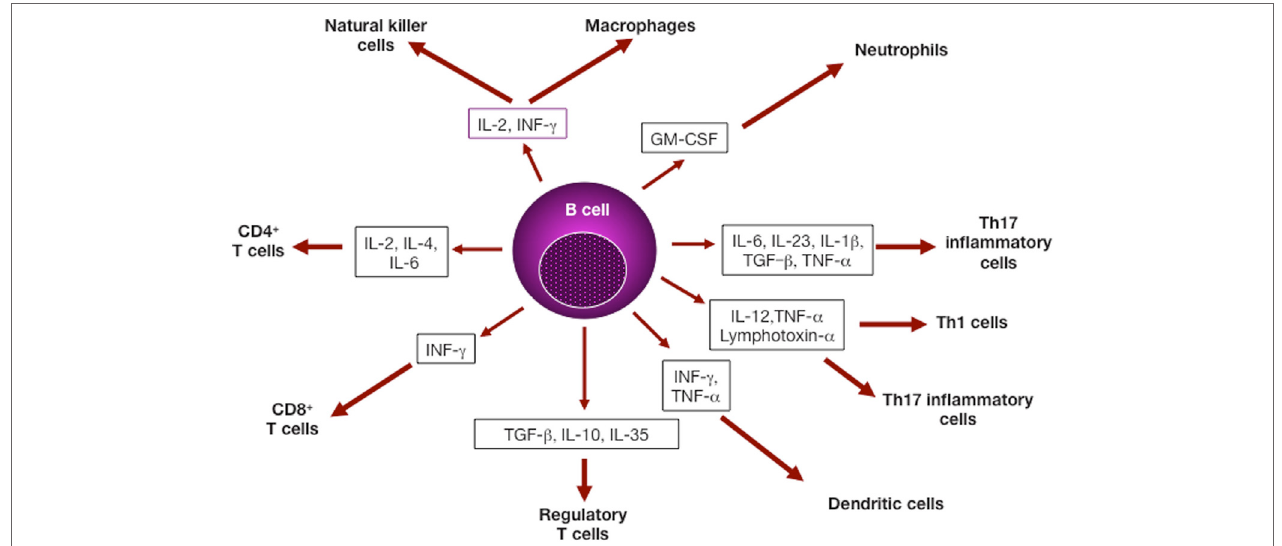
FigURe 1 | B lymphocytes and cytokine production. Cytokines derived from B cell subsets can impact several cell types of both the adaptive and the immune systems, and affect cell differentiation and/or effector function